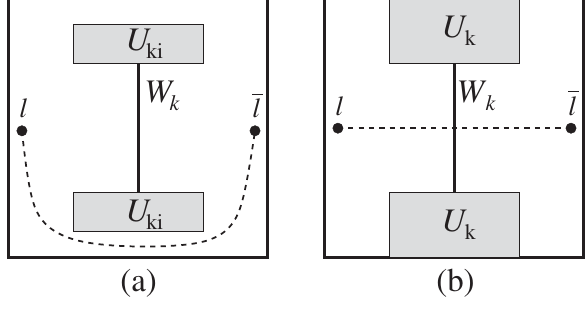
FIG. 9. The state j (cid:2) ex i can be written as j (cid:2) ex i ¼ W l(cid:11) j (cid:2) i , where W l(cid:11) is a stringlike operator with path (cid:11) . This equation holds for any choice of (cid:11) . (a) To prove (C20), we choose (cid:11) (dotted line) so that it avoids the region of support of (b) To prove (C27), we choose (cid:11) so that it intersects W k